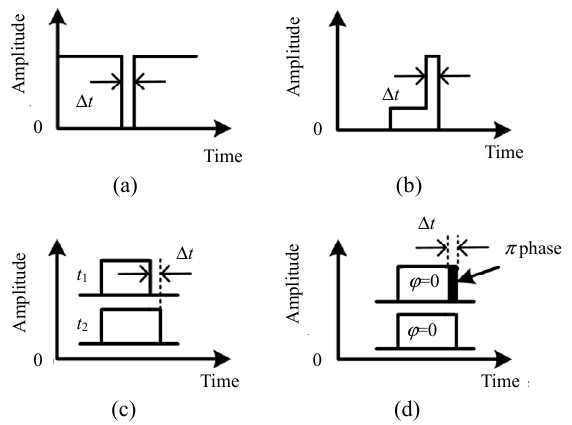
Fig. 1 Principle of distributed sensing based on backward stimulated Brillouin scattering.